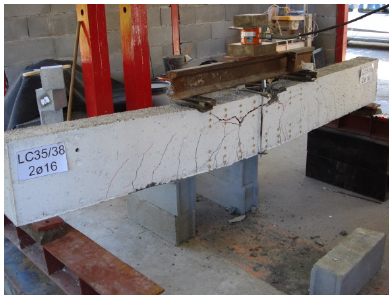
(assuming a mechanism). The experimental and theoreti- cal elastic rotations were obtained by multiplying the cor- responding curvatures (theoretical and experimental) by a length of 1.2 h , being h the height of the cross-section (Fig. 5). This length, according to Eurocode 2 – EC2 (NP EN 1992-1-1 2010), corresponds to the length of the local plastic hinge of beams with ductile failure. The theoretical elastic curvatures were calculated from the elastic stress and strain diagrams, assuming a pure bending state acting on the homogenized section of the beams. The theoretical elastic deflections of the beams at mid-span were calcu - lated using tables to compute elastic deflections. Since the slopes of the straight lines for the TEA are very similar, only an average straight line was drawn in the graphs of Figures 4(a) to 4(c). To compute the theoretical plastic rotation- deflection relationship (Eqn (1)), a global mecha - nism with a plastic hinge located at the mid-span section was assumed (Fig. 6):